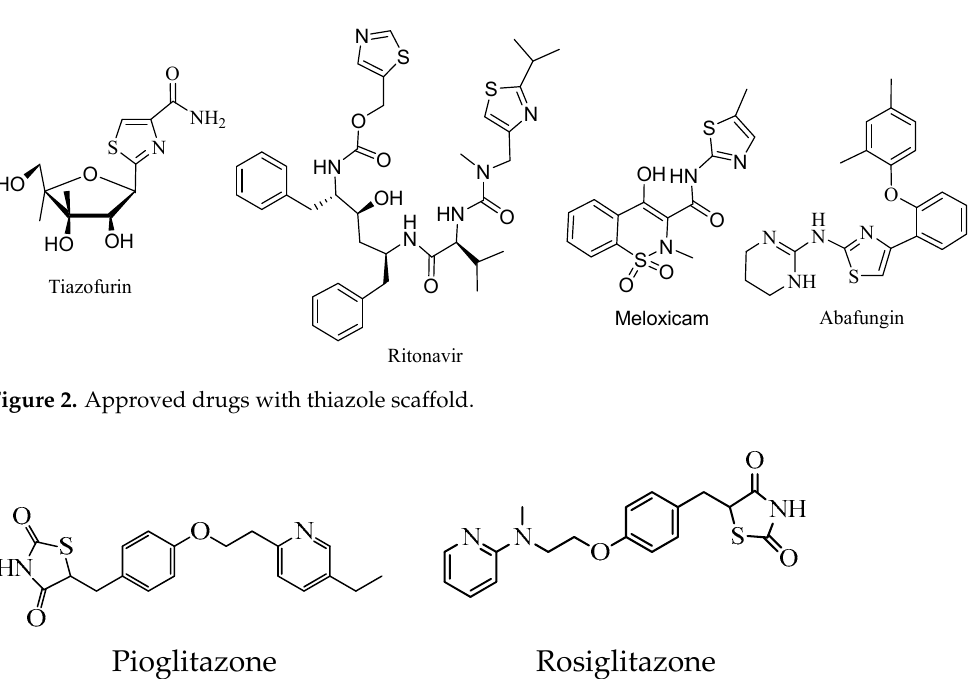
Figure 3. Approved drugs with thiazolidinone scaffold.